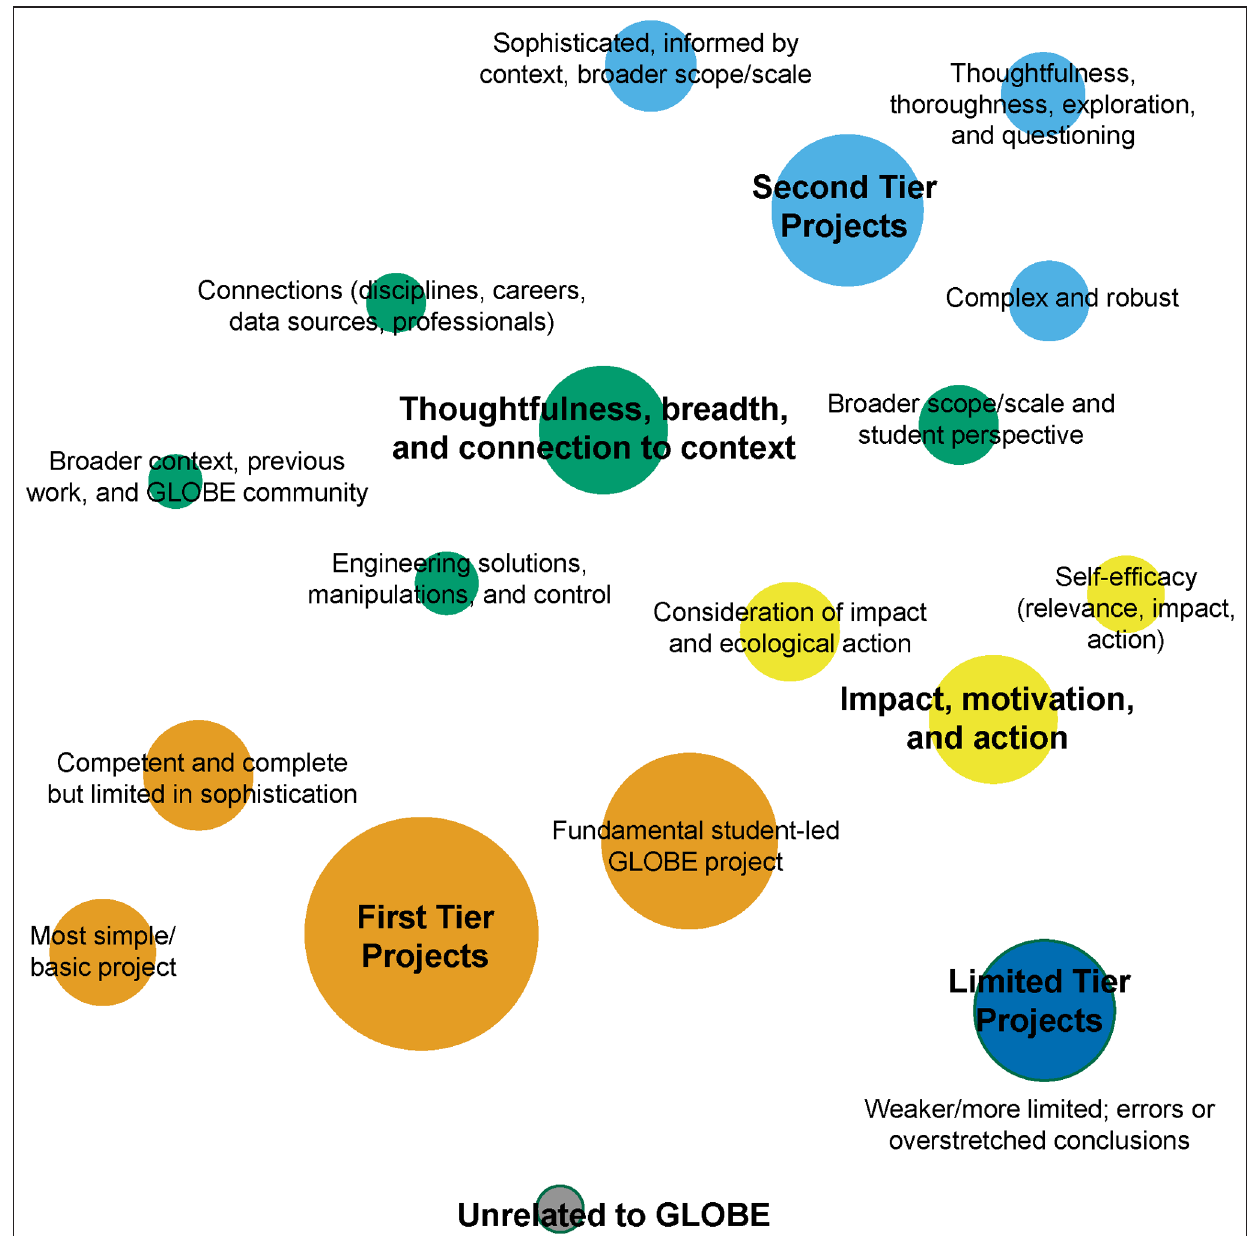
Figure 2 Concept map framework of project typologies based on cluster analysis and theoretical